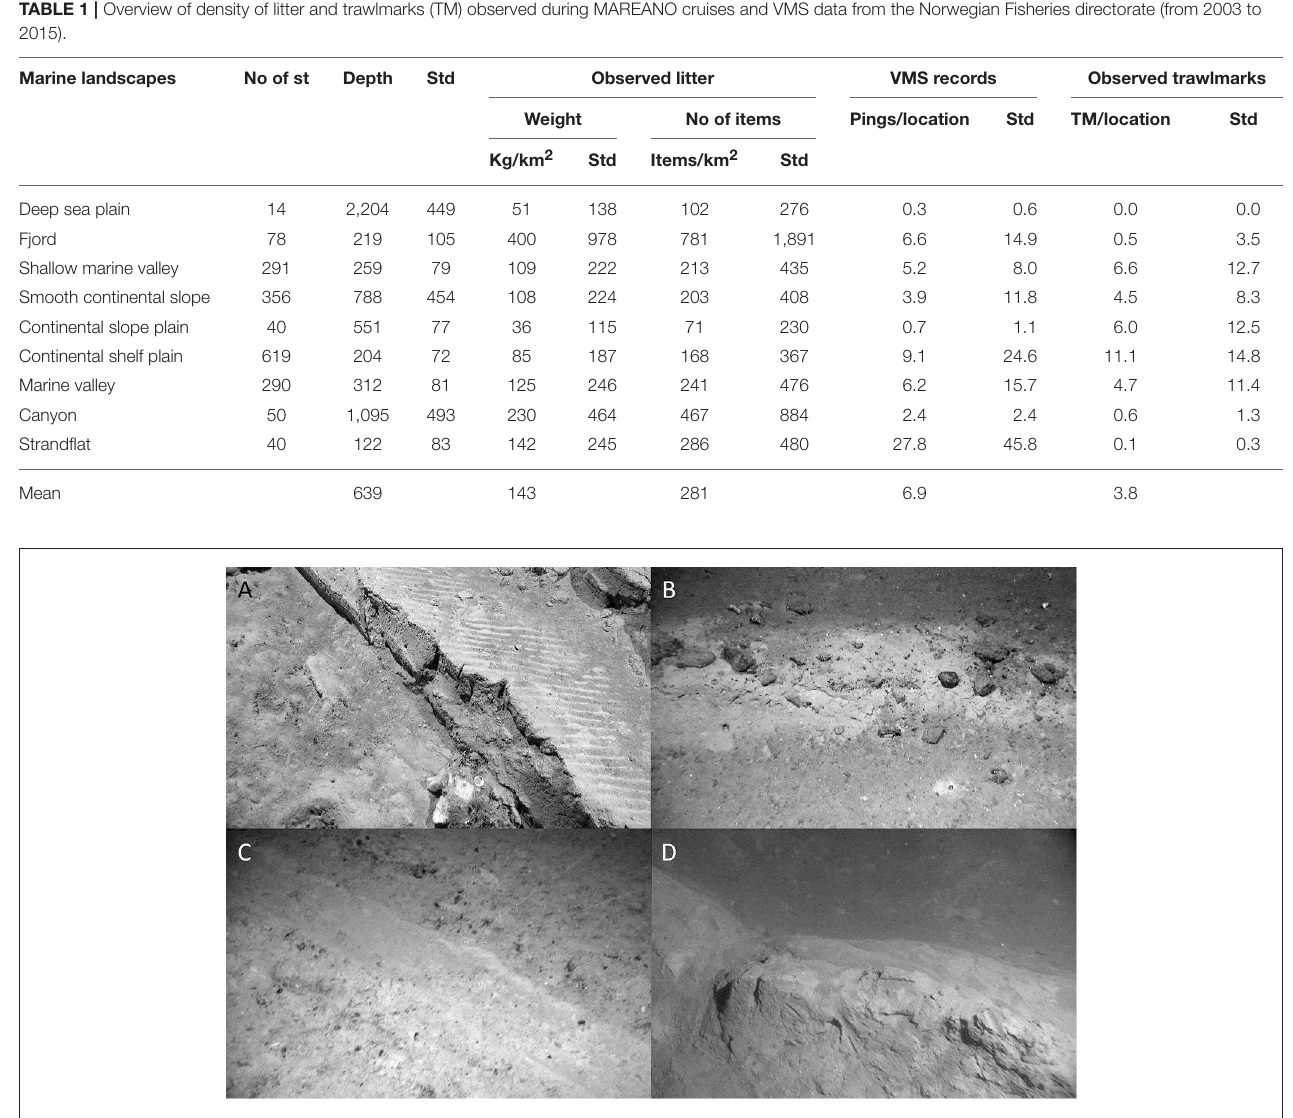
FIGURE 2 | Examples of trawl marks observed on soft (A,D) and mixed bottoms (B,C) during MAREANO seabed video